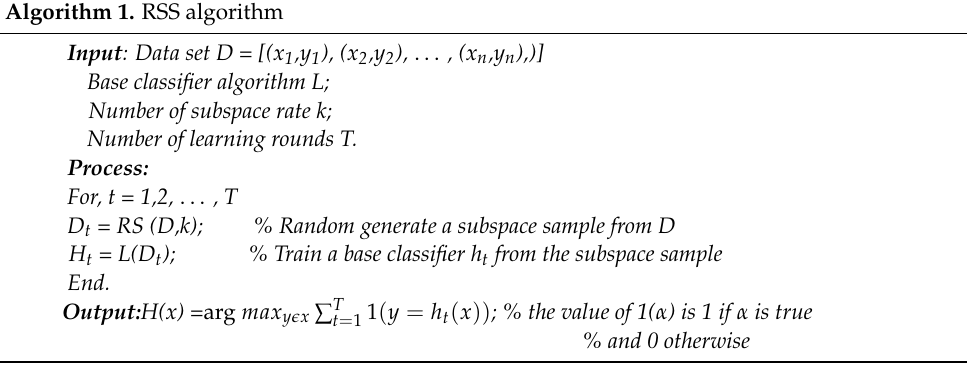
Algorithm 1. RSS